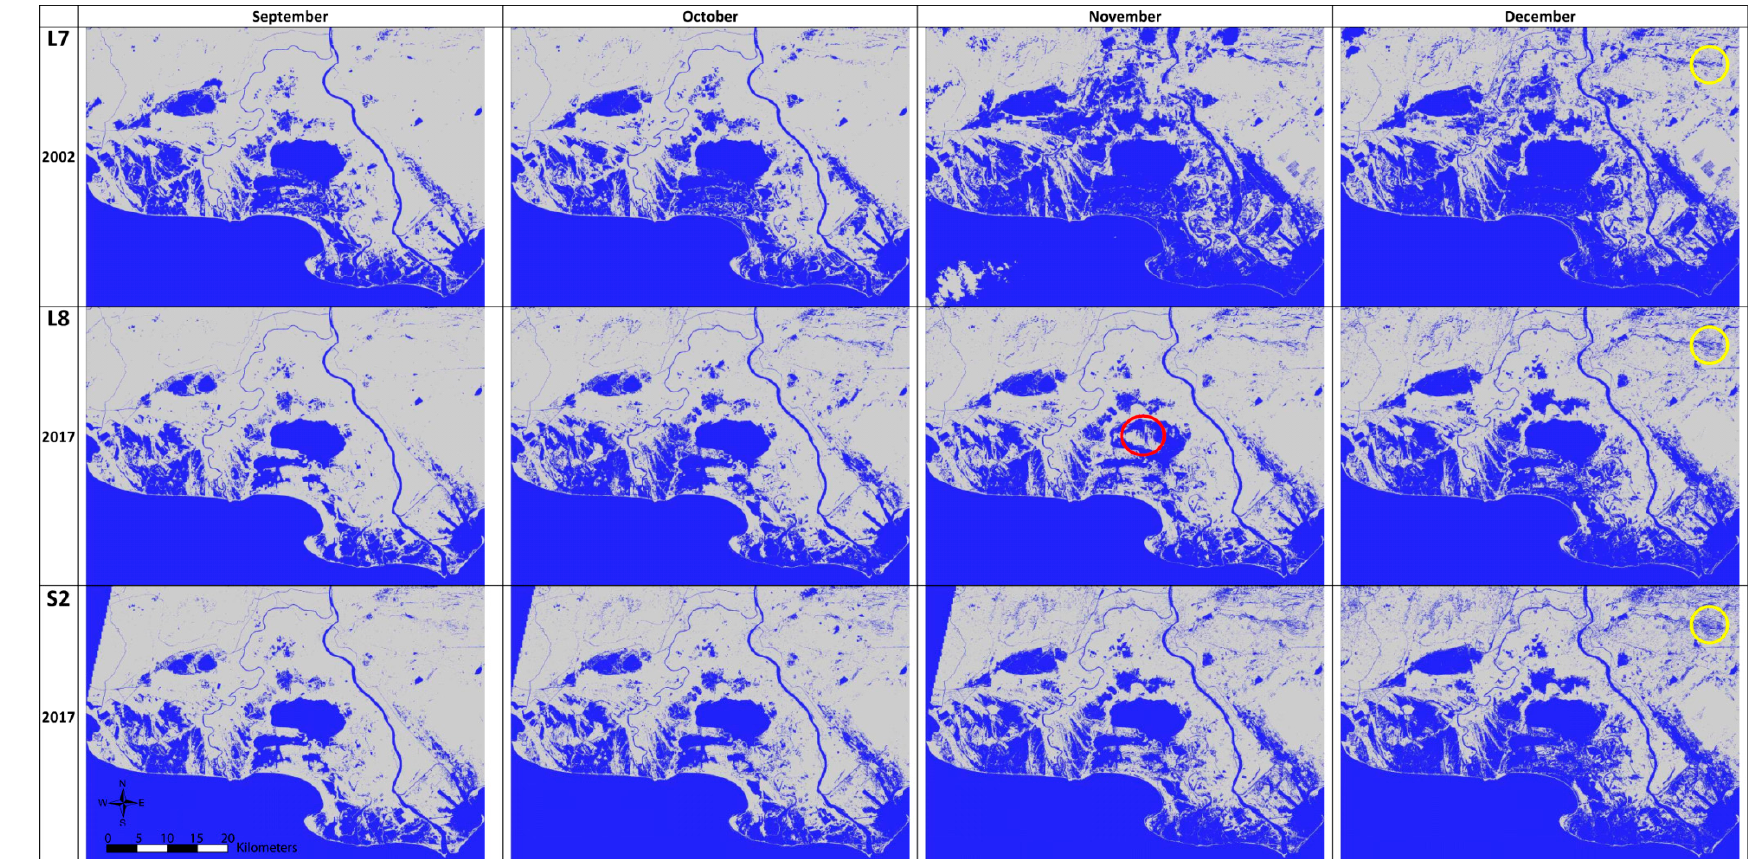
Figure 4. Impact of precipitations received in the month preceding scene acquisition from September through December based on single water masks (one scene per month showing water presence / absence) produced with Landsat 7 (328 mm in 2002), Landsat 8 (67 mm in 2017) and Sentinel 2 (89 mm in 2017). The red circle refers to noises caused by waves on a windy day, while the yellow circles enclose misclassifications due to shadows in a mountainous area.